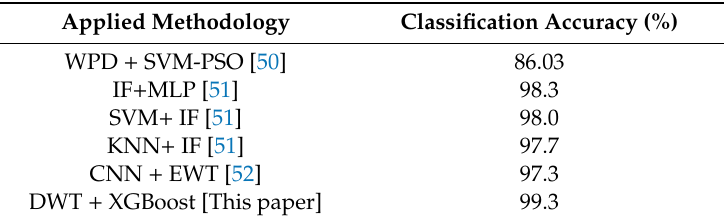
Table 8. Comparison of classification accuracy among the various